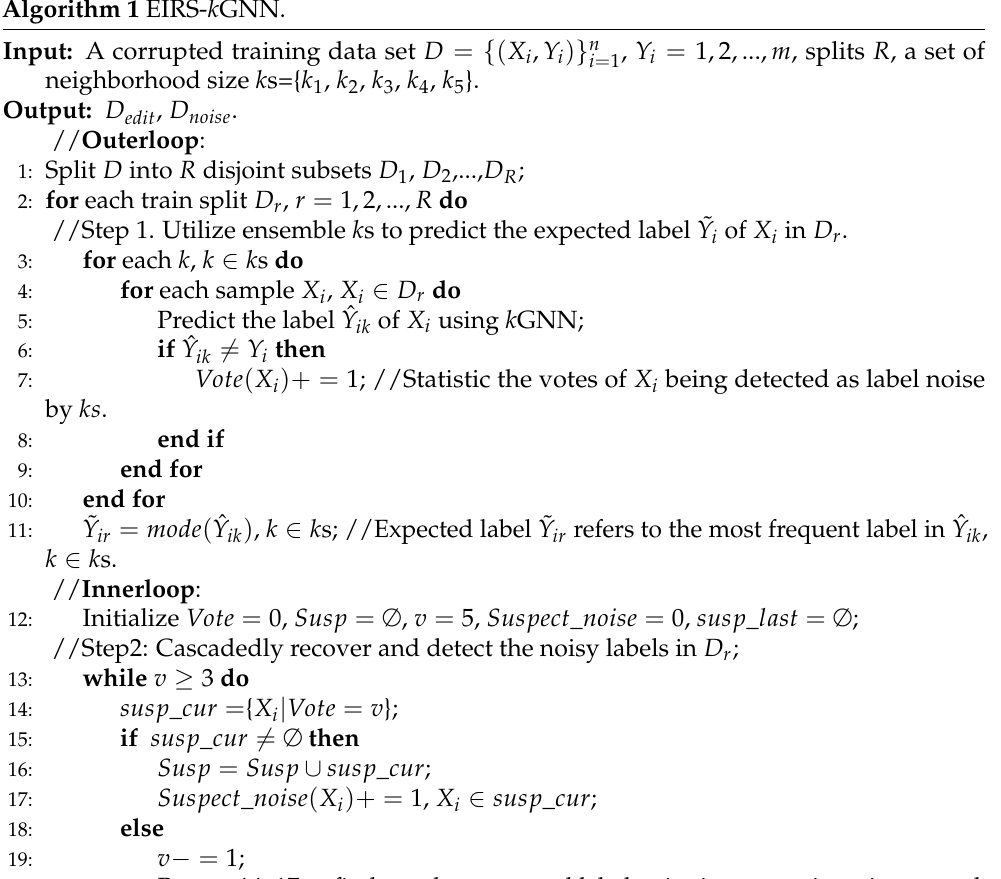
Algorithm 1 EIRS- k